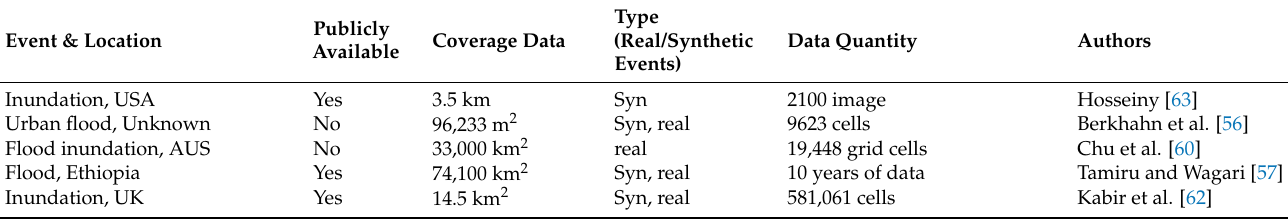
Table 4. Summary of datasets used in the reviewed